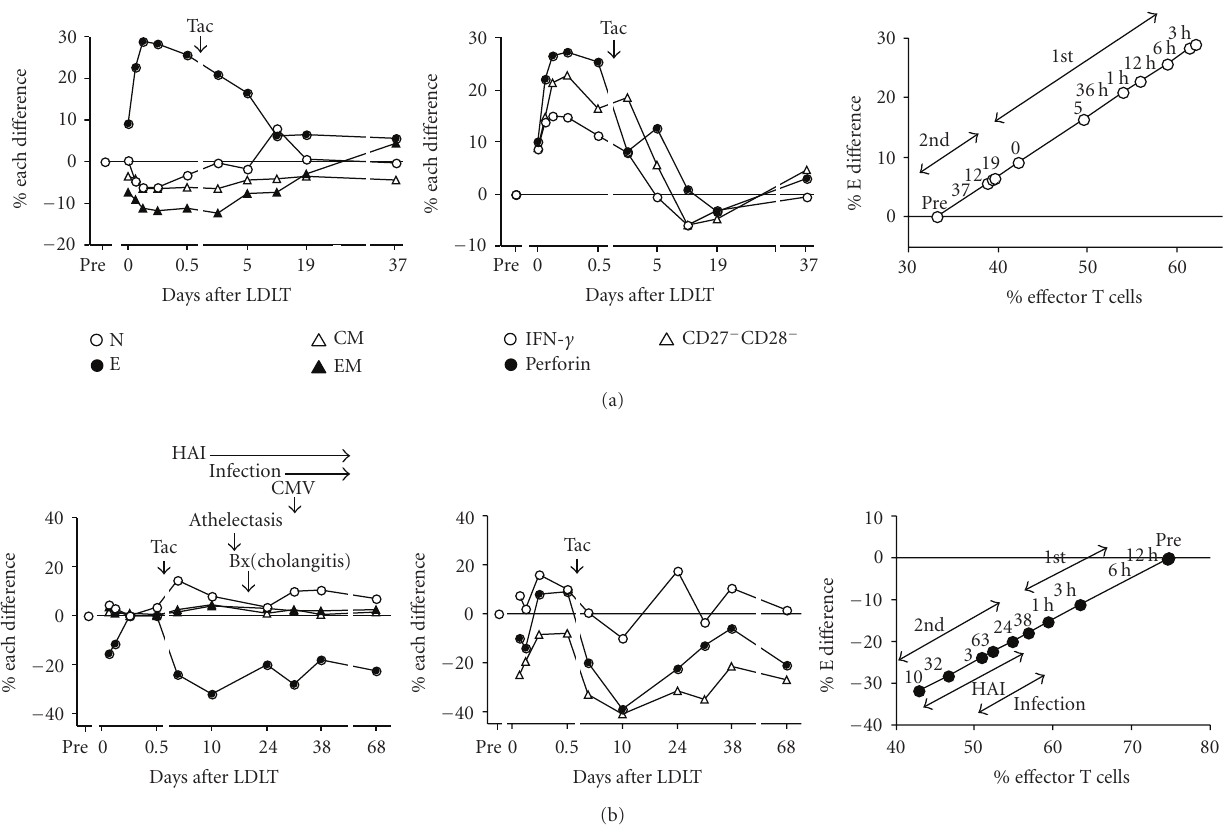
Figure 6: (a) Changes in % di ff erence in CD8 + naive, CM, EM, and e ff ector T cells, as well as IFN- γ , perforin, and CD27 − CD28 − subsets in a 62-year-old male recipient undergoing LDLT to treat HCV-related liver cirrhosis and hepatocellular carcinoma. Right, scatter plot between % E di ff erence and % e ff ector T cell proportion. 1st phase is the period before Tac administration. 2nd phase is the period after Tac administration. Pre, pre-LDLT; Tac, tacrolimus; the number above black circles in right figure, postoperative days. Left figure: N, naive T cells; E, e ff ector T cells; CM, central memory T cells; and EM, e ff ector memory T cells. Middle figure: IFN- γ , interferon-gamma; and CD27 − CD28 − , CD27 − CD28 − subsets. (b) Posttransplant changes in % di ff erence in CD8 + T cell subsets as well as IFN- γ , perforin, and CD27 − CD28 − subsets in a 60-year male recipient undergoing to treat HBV-related liver cirrhosis and hepatocellular carcinoma. Right, Scatter plot between % E di ff erence and % e ff ector T cell proportion. 1st phase is the period before Tac administration. 2nd phase is the period after Tac administration. Pre, pre-LDLT; Tac, tacrolimus; HAI, hepatic artery flow interruption; Bx, biopsy; the number above black circles in right figure, postoperative